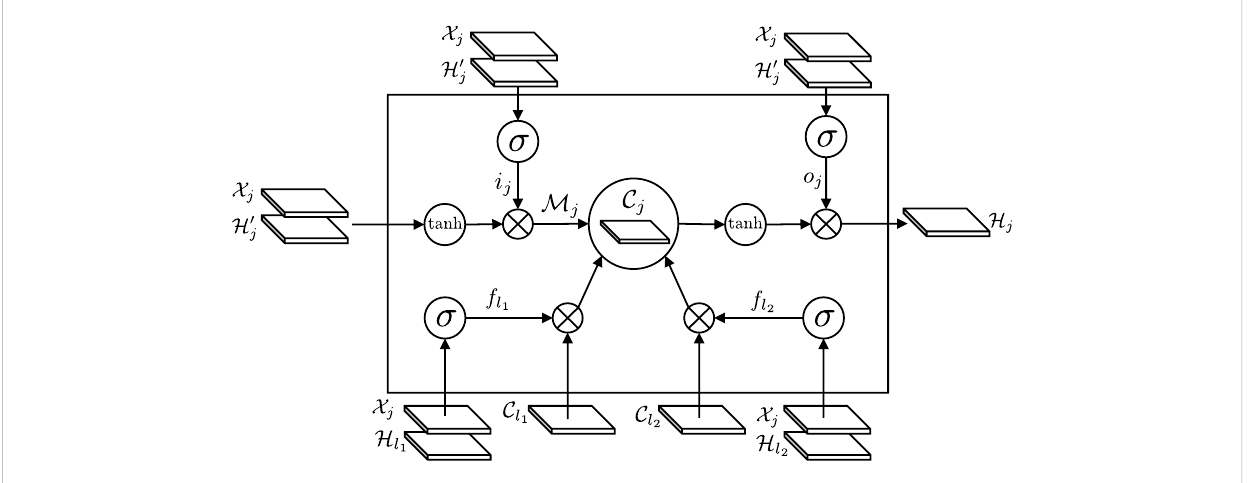
FIGURE 1 The work fl ow of the tree-structured ConvLSTM. The gating mechanism of our tree-structured ConvLSTM is similar to LSTM, with two distinct differences. First, the gating signals in tree-structured ConvLSTM is 2D feature maps, instead of feature vectors in the standard LSTM. Second, tree- structuredConvLSTMhastoconsiderthescenarioswithmorethanonechild.Asthecurrentnode j hastwochildren, l 1 and l 2 ,twoforgetgates(i.e., f l f l ) are used to regulate the information fl ow from the memories ( M l 2 controlled by the input feature map X j and the sum of hidden states of its children nodes H j ′